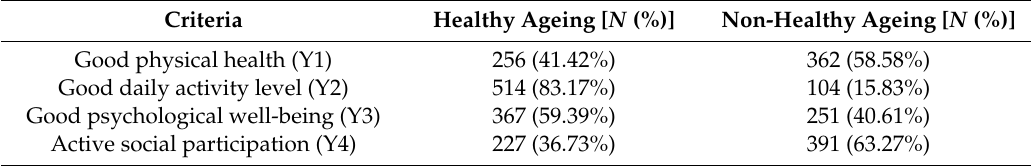
Table 3. Proportion of healthy ageing among Chinese rural older people [ N